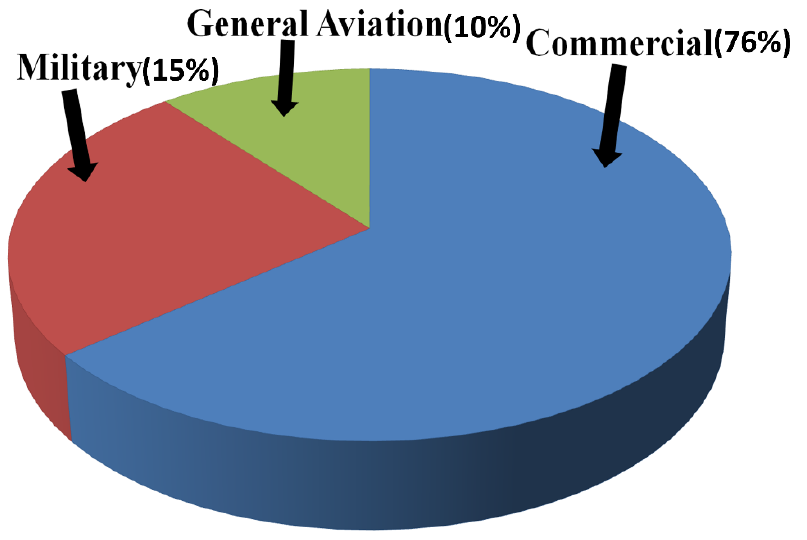
Figure 2. Aircraft engine market size in 2019 for turbine blade